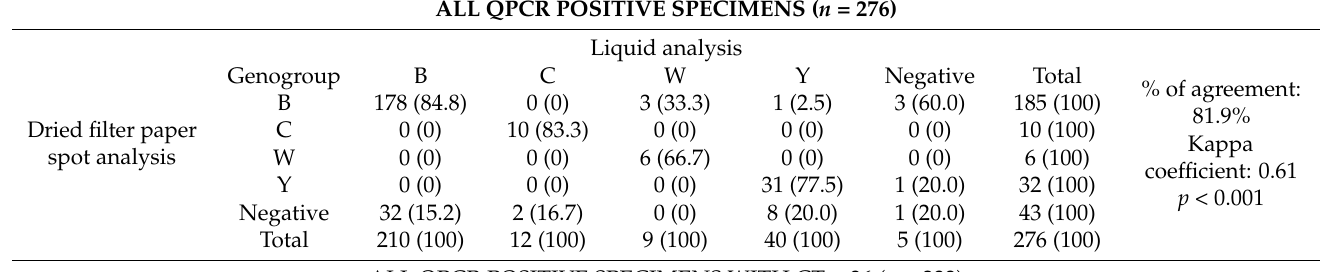
Table 2. Agreement between genogrouping from dried spot extracts and liquid specimen extracts. ALL QPCR POSITIVE SPECIMENS ( n = 276)